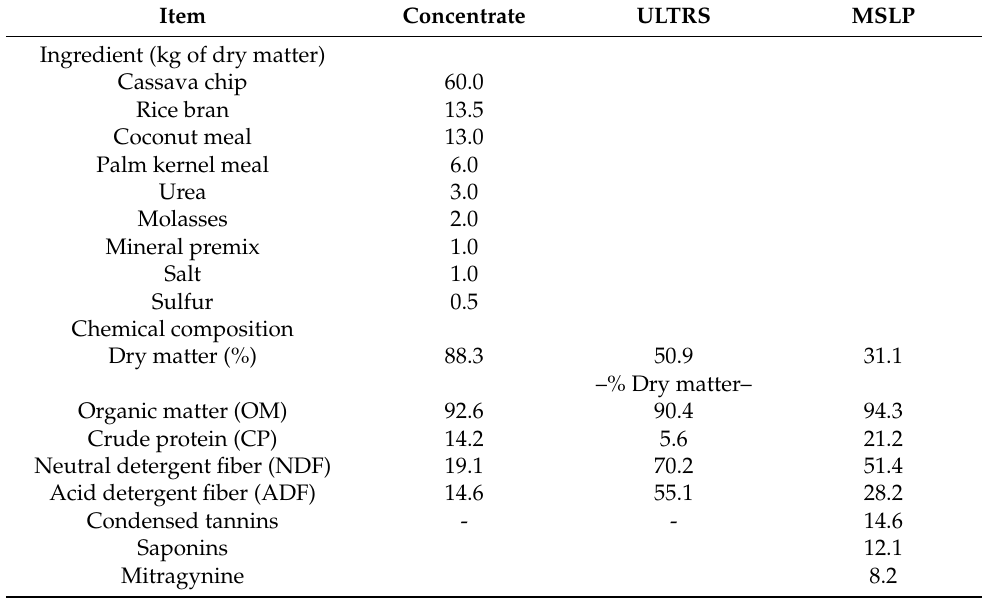
Table 1. Ingredients and chemical composition of concentrate, Mitragyna speciosa Korth leaves powder (MSLP) and 2% urea plus 2% calcium hydroxide (Ca(OH) 2 ) treated rice straw (ULTRS) used in the